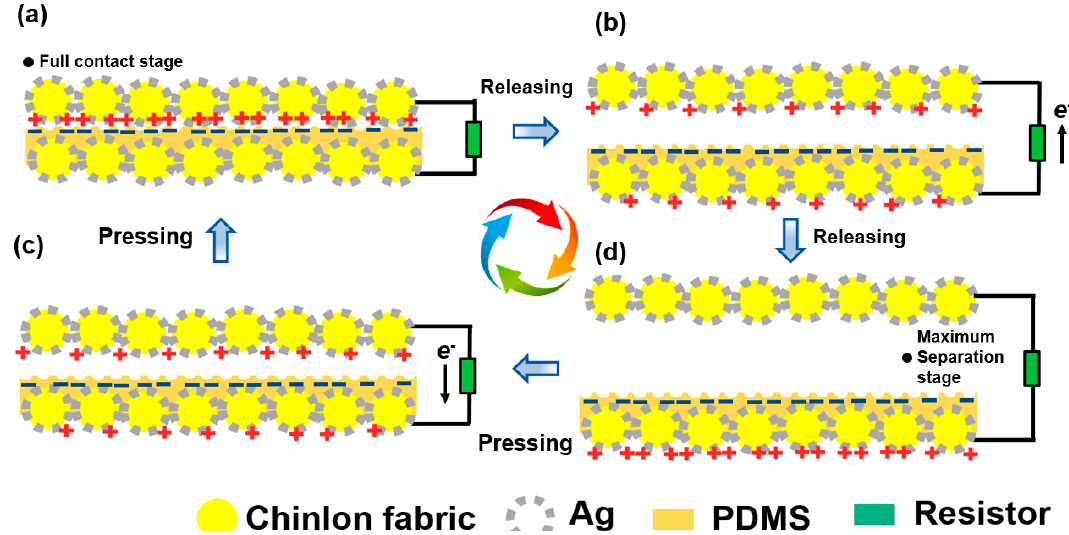
Figure 4. Working operation of T-TENG. ( a ) Full contact stage. ( b ) Releasing process from the full contact stage to maximum separation stage. ( c ) Maximum separation stage. ( d ) Pressing process from the maximum separation stage to full contact stage.